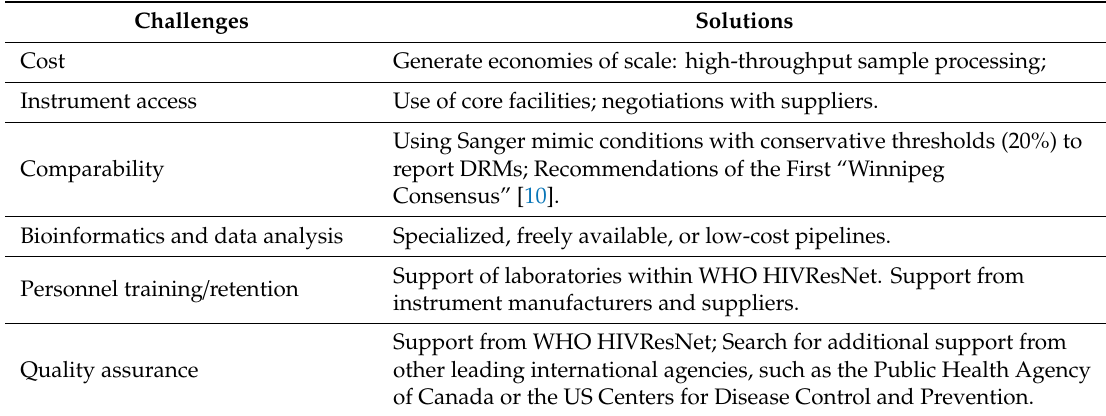
Table 4. NGS implementation in resource-poor settings, feasibility, and